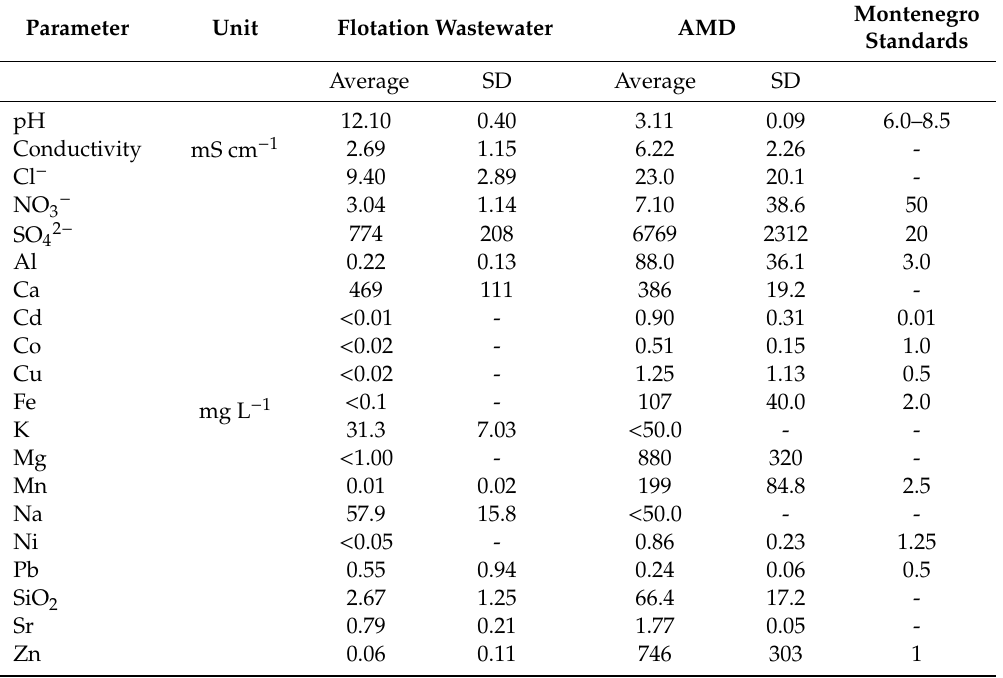
Table 4. General characteristics of acid mine drainage (AMD) and flotation wastewater.